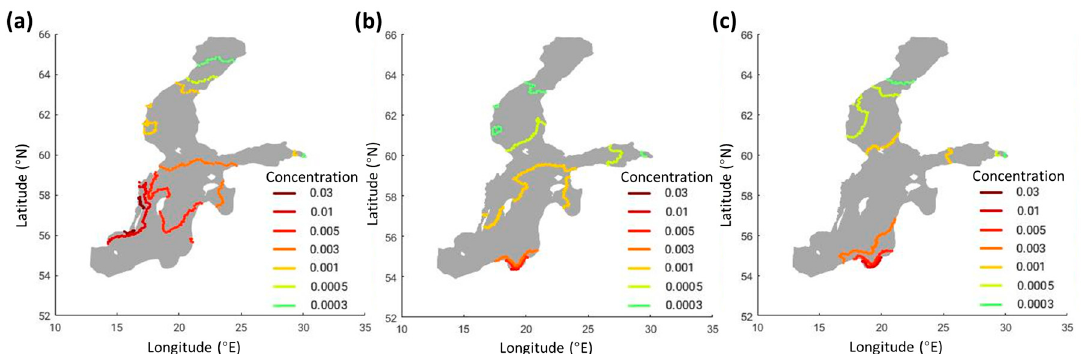
Figure 9. Isolines of maximum solute concentration over the simulation period for the per-capita nutrient release scenario. ( a ) Kalmar County coast case with standard solute release; ( b ) Vistula River coast case with TN-proportional 4.3 times lower solute release; ( c ) Vistula River coast case with TP-proportional 2.7 times lower solute release.